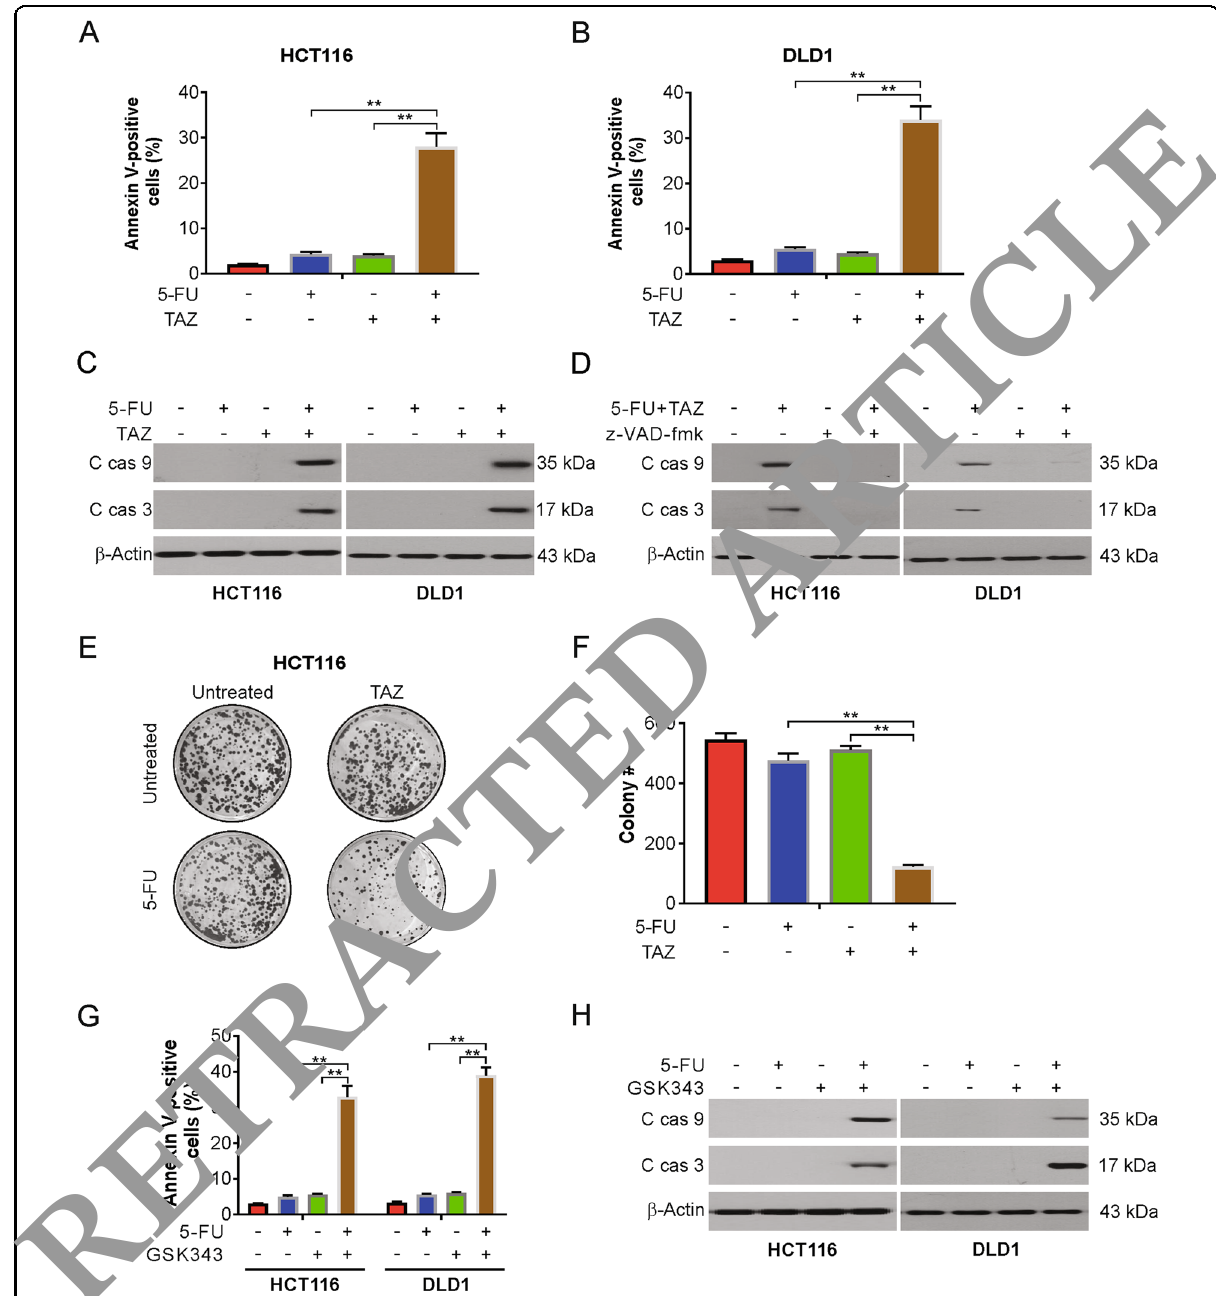
Fig. 2 Tazemetostat enhanced 5-FU-mediated apoptosis in CRC cells. A , B HCT116 cells were treated with 2.5 μ g/mL 5-FU, 0.5 μ M tazemetostat, or their combination for 24 h. Apoptosis was analyzed by fl ow cytometry. C HCT116 or DLD1 cells were treated with 2.5 μ g/mL 5-FU, 0.5 μ M tazemetostat, or their combination for 24 h. Indicated proteins were analyzed by western blotting. D HCT116 or DLD1 cells were treated with the combination of 2.5 μ g/mL 5-FU and 0.5 μ M tazemetostat with or without z-VAD-fmk pretreatment for 24 h. Indicated proteins were analyzed by western blotting. E , F HCT116 cells were treated with 2.5 μ g/mL 5-FU, 0.5 μ M tazemetostat, or their combination for 2 h. After 2 weeks, the plates were stained for cell colonies with crystal violet dye. G HCT116 or DLD1 cells were treated with 2.5 μ g/mL 5-FU, 1 μ M GSK343, or their combination for 24 h. Apoptosis was analyzed by fl ow cytometry. H HCT116 or DLD1 cells were treated with 2.5 μ g/mL 5-FU, 1 μ M GSK343, or their combination for 24 h. Indicated proteins were analyzed by western blotting. The results were expressed as the mean ± SD of three independent experiments. ** P < 0.01.